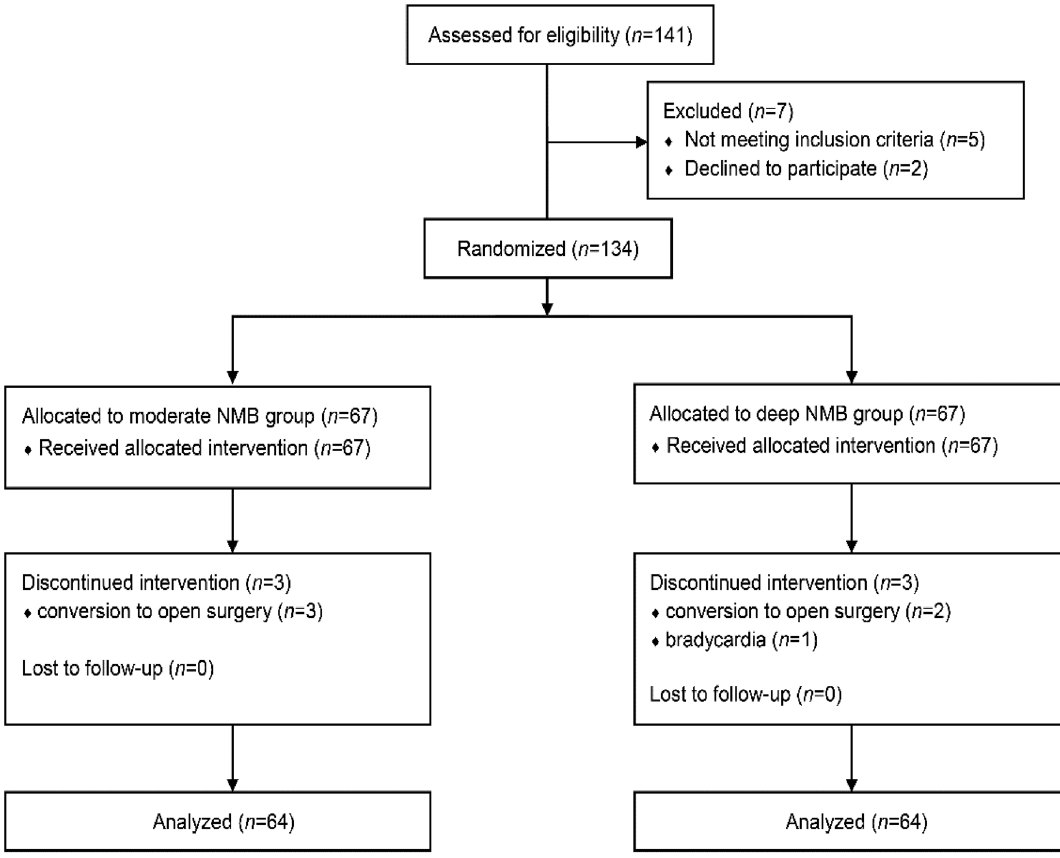
Figure 1. The CONSORT flow diagram of patient enrollments. NMB, neuromuscular